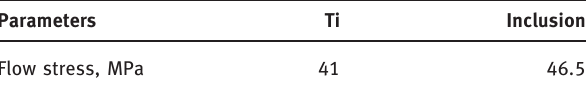
Table 5: Flow stress.